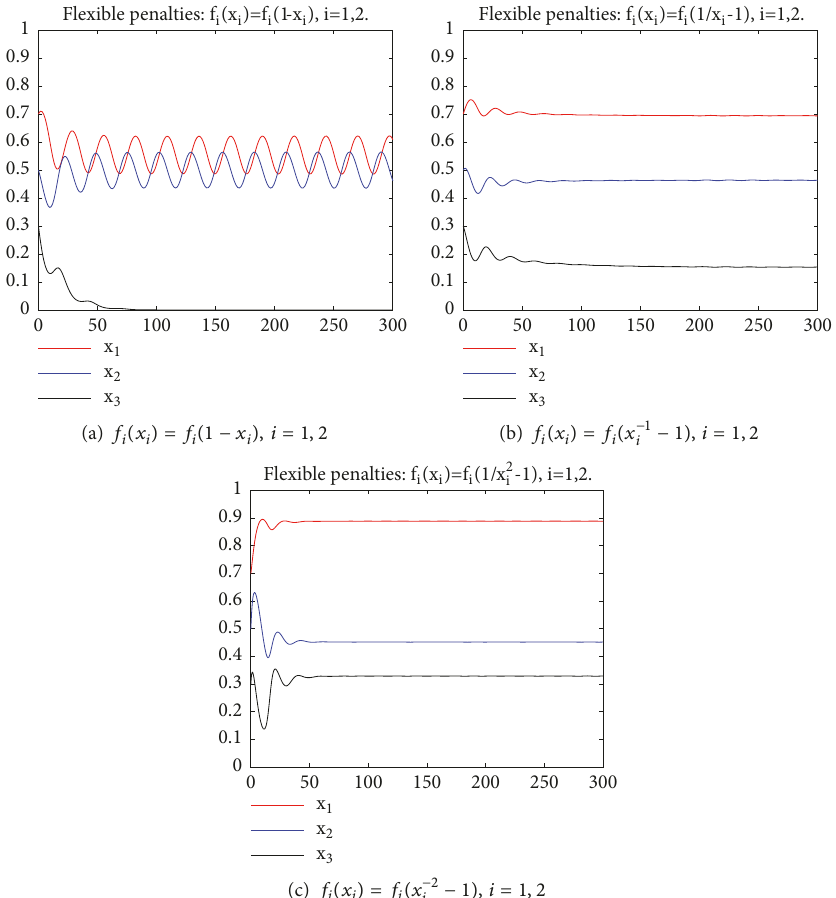
Figure 9: Time series graph of dynamical system under flexible penalty mechanism. Initial value is 𝑃 1 (0.7,0.5, 0.3)